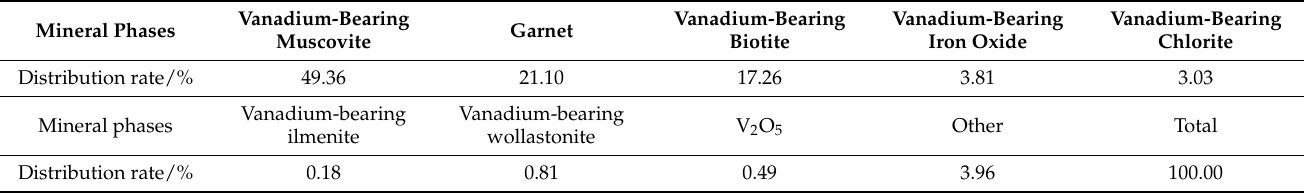
Table 6. Vanadium phase